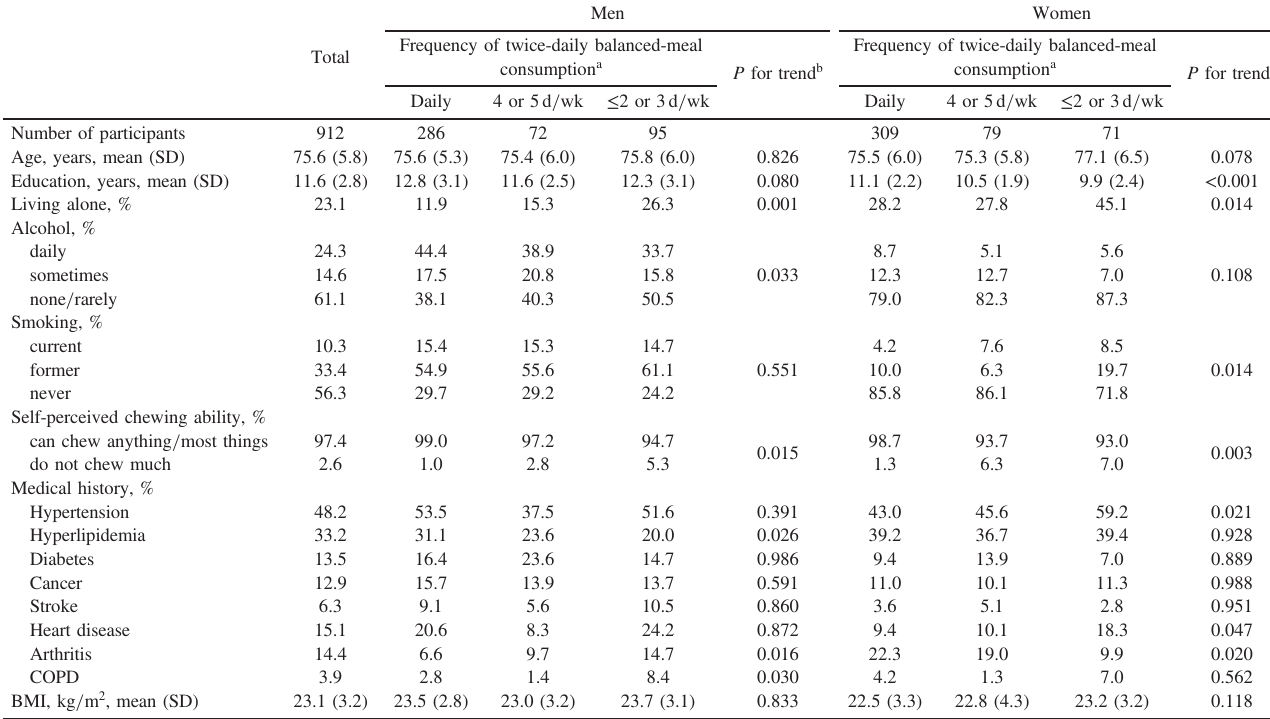
Table 1. Participant characteristics in relation to frequency of twice-daily balanced-meal consumption Men Women Frequency of twice-daily balanced-meal Frequency of twice-daily balanced-meal Total consumption a P for trend b consumption a P for trend b Number of